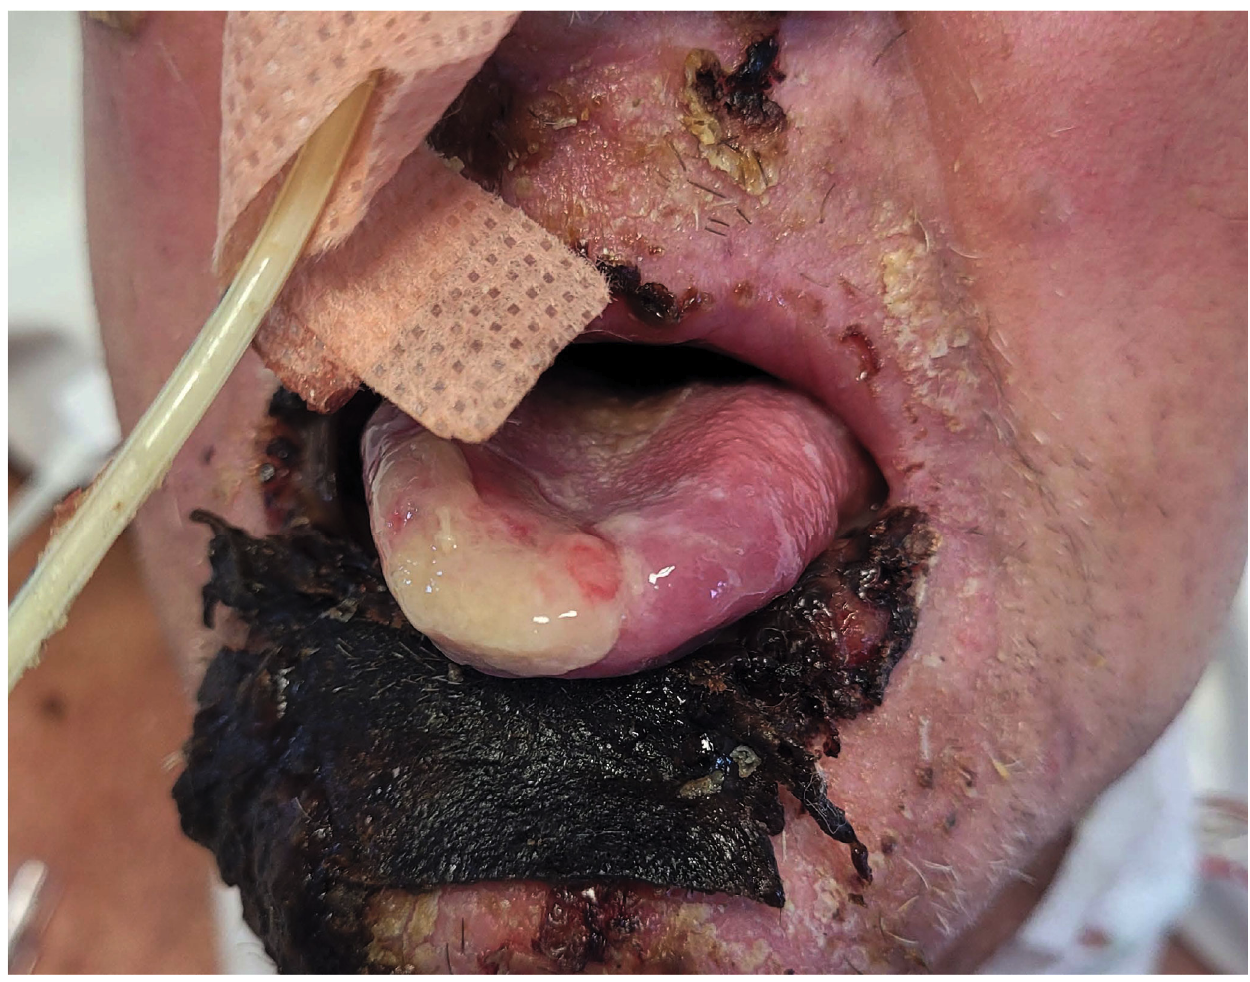
Figure 2: Tongue after division of fused tissues with full range of